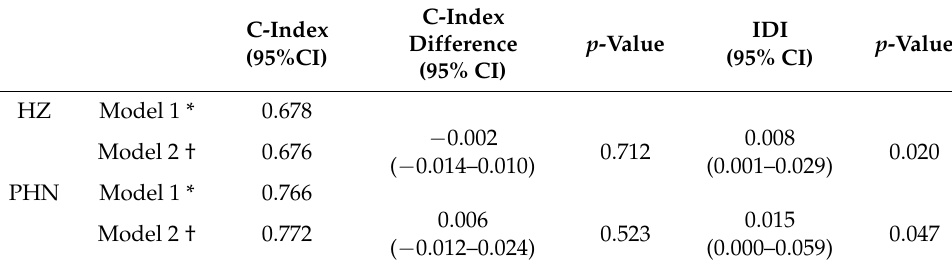
Table 4. Predictive models for herpes zoster and postherpetic